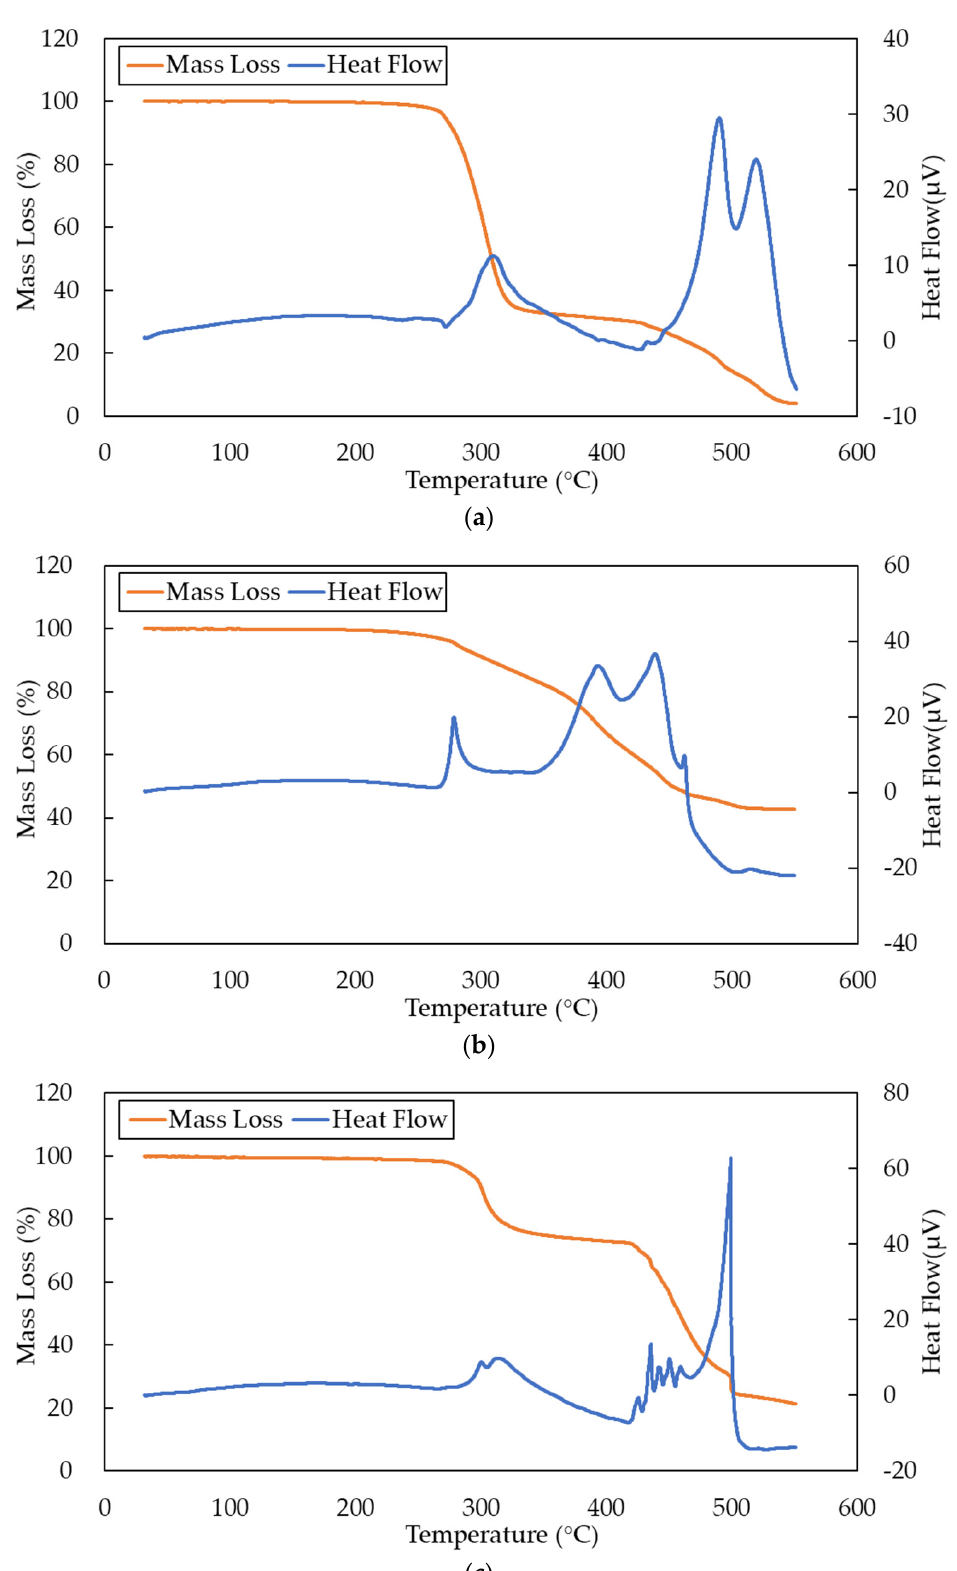
Figure 3. Results of differential thermal and thermogravimetric analyses of three types of cable. ( a ) LV cable; ( b ) MV cable A; ( c ) MV cable B.